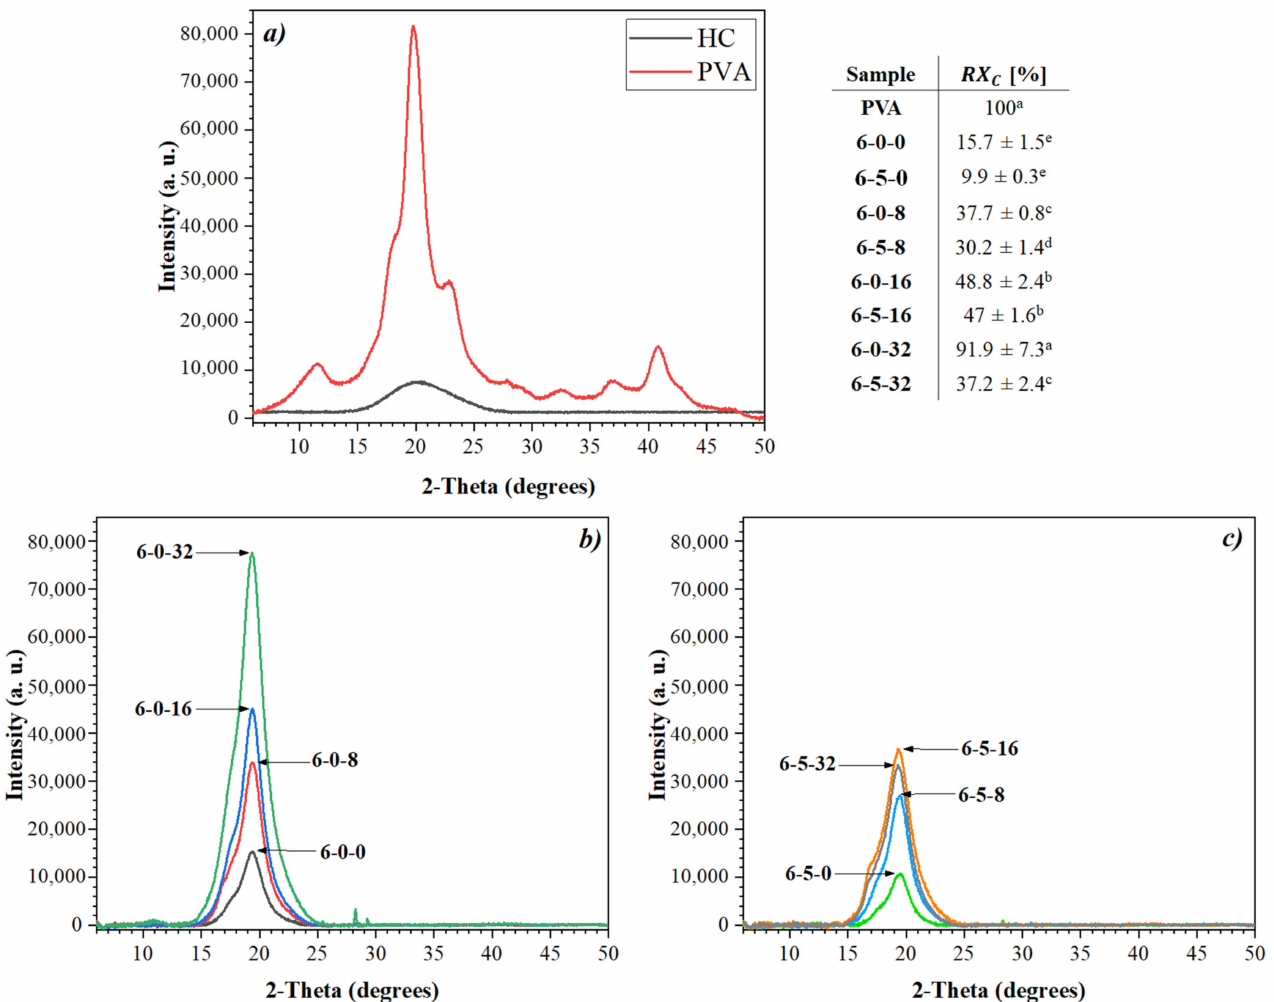
Figure 6. X-ray diffraction patterns: ( a ) PVA and HC ( b , c ) biomembranes produced by electrospinning with PVA/HC/EEHP. (Nomenclature: % PVA (6)—% hydrolyzed collagen (0, 5)—% EEHP (0, 8, 16, 32)). RX —relative crystallinity percentage. In the table, same letters in the same column indicates no significant difference between the data ( p < 0.05). Nomenclature: % PVA (6)—% hydrolyzed collagen (0, 5)—% EEHP (0, 8, 16,